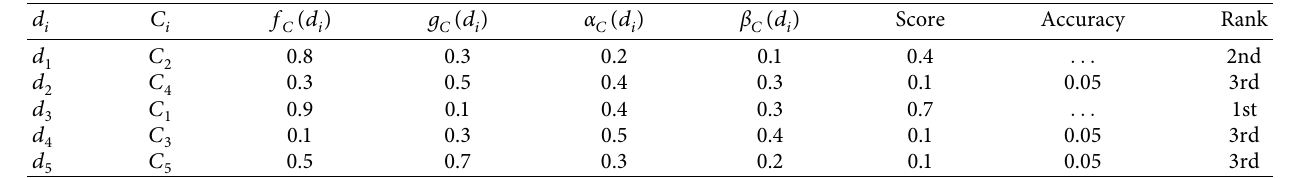
Table 16: LDFNs C s along with scores, accuracies, and i